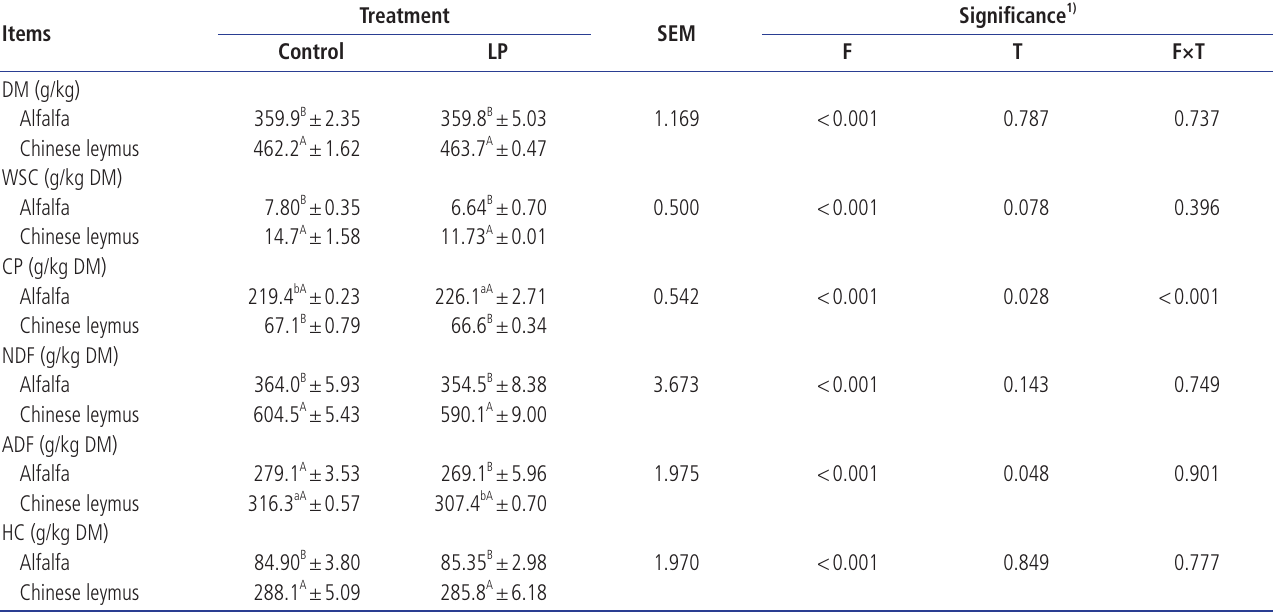
Table 3. Chemical compositions of alfalfa and Chinese leymus silages